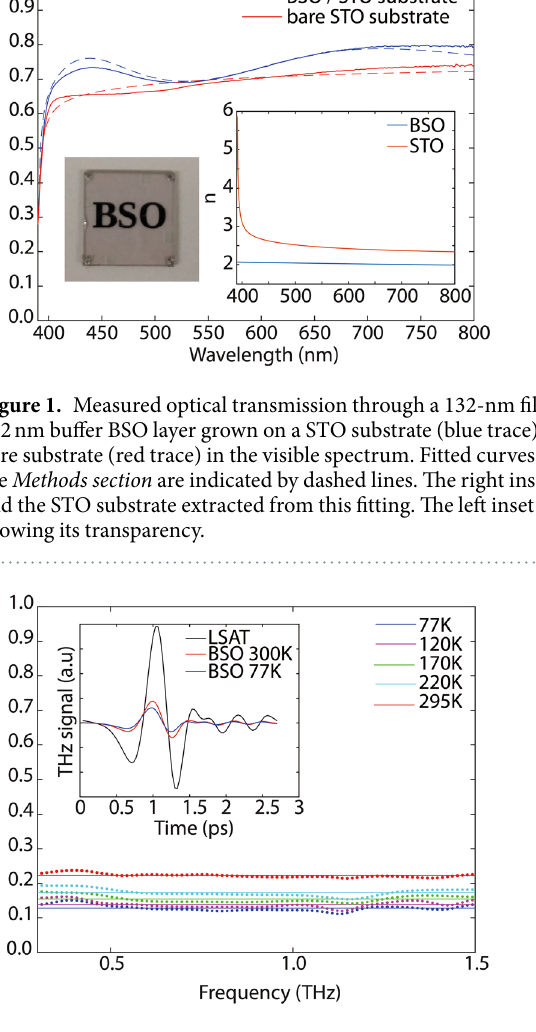
Figure 2. Measured terahertz transmission through Sample #1. The transmission is normalized to that of a bare substrate at each temperature. The experimental data points are indicated with dots, whereas fits to the model discussed in methods section are depicted with solid lines. The inset shows the measured terahertz pulse through the LSAT substrate at room-temperature as well as the pulses through Sample #1 at room-temperature and 77